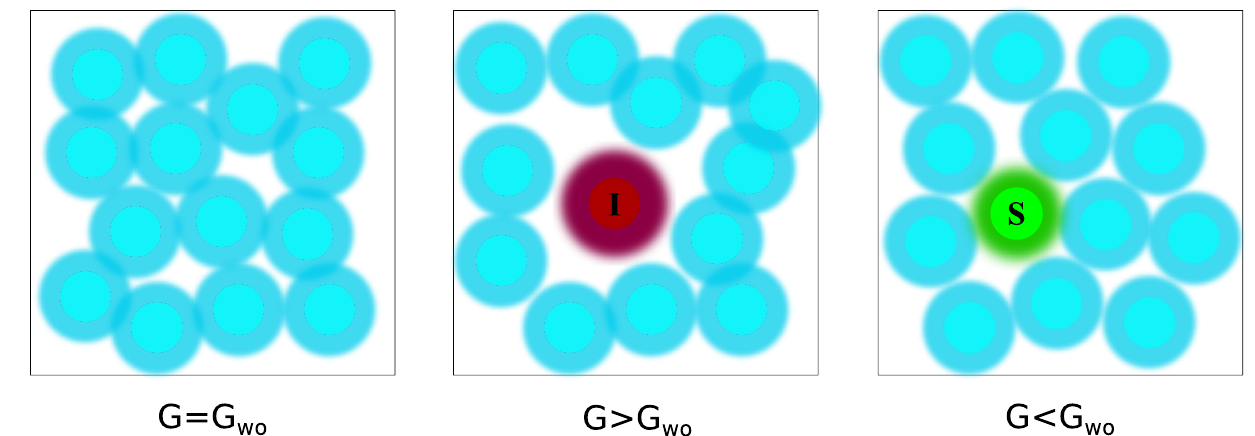
Figure 10. Schematic representation of three similar simulation boxes. Inner circles represent the regions of strong repulsion (overlapping electronic clouds), outer stand for van der Waals attraction (except for the red, insoluble I molecule). On the left panel, a purely aqueous system is presented; in the middle, a hydrophobic molecule is put into an aqueous environment; the right panel demonstrates the system with a hydrophilic